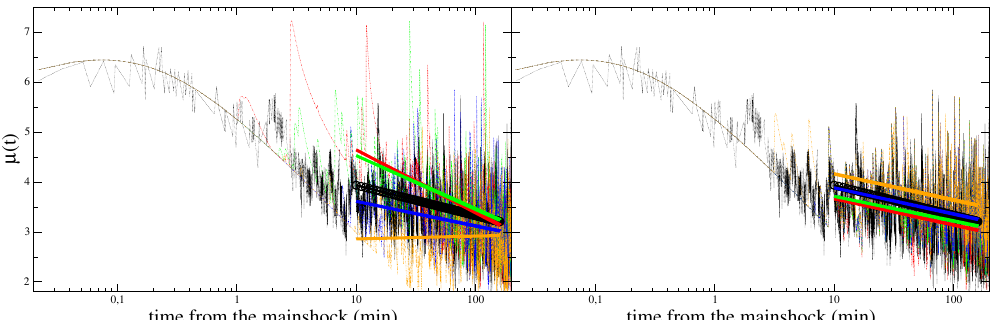
Figure 10. ( Left ) Black dotted-lines represent the envelope function µ e ( t ) of the Lixouri earthquake in Greece recorded at the station LKD2 located at 70 km from the mainshock epicenter. Colored dot-dashed lines are used for µ th ( t ) with τ = 11 s, K = 1.15 and different values of c ranging in the interval [ 0.01,4.5 ] days. Black circles represent the logarithmic fit (Equation (15)) in the interval [ 10,160 ] min of the experimental envelope function, whereas continuous lines are used for the best fit of the numerical µ th ( t ) , with c increasing from 0.01 to 4.5 days from top to bottom. ( Right ) The same as in the left panel but plotting numerical data µ th ( t ) with τ = 11 s, c = 1.15 days and different values of K ∈ [ 0.75,2.95 ] . Continuous lines are the the logarithmic fits of numerical data, in [ 10,160 ] min, with K increasing from bottom to top. From Reference